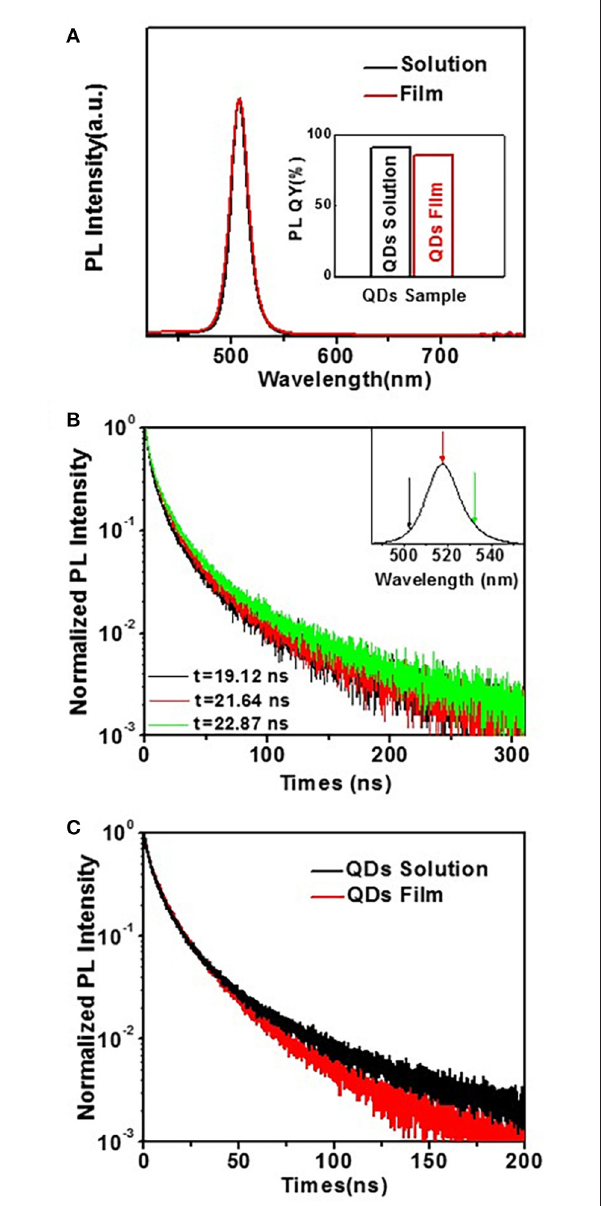
FIGURE 3 | (A) PL emission of CsPbBr 3 QDs (synthesized at 150 ◦ C) in the forms of solution vs. solid thin film. Inset: Comparison of PL QYs of CsPbBr 3 QDs in the forms of solution vs. solid film. (B) PL decay curves obtained from perovskite CsPbBr 3 QDs at different emission wavelengths indicated by the color coded arrows in the insets. (C) PL decay curves of diluted hexane solution of perovskite CsPbBr 3 QDs (black line) vs. films of the QDs layer (red